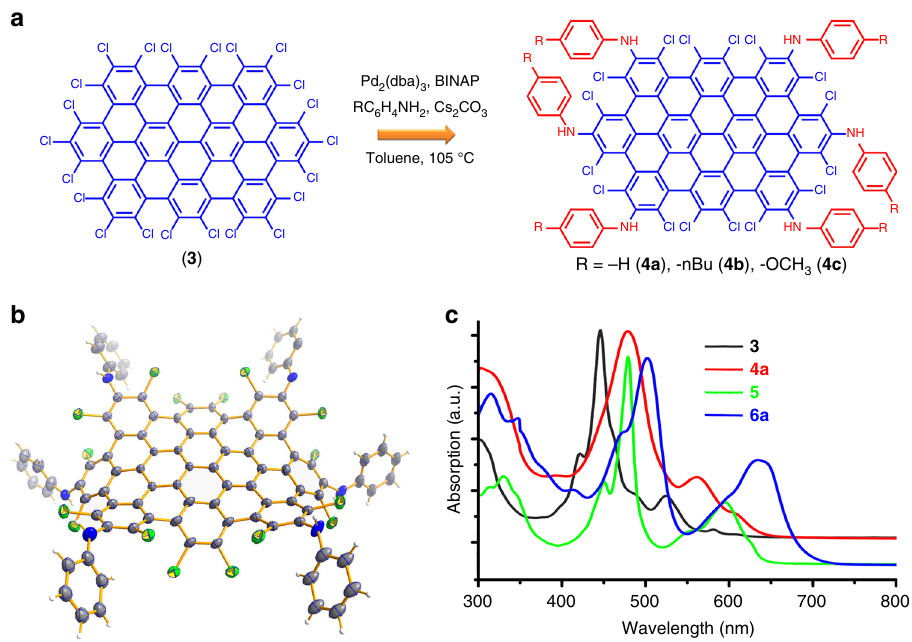
Fig. 4 Synthesis and crystal of 4 and optical absorption. a optimized synthetic route for 4 . b the crystal structure of 4 represented by 4a . The thermal ellipsoids were set at 30% probability level. c UV-Vis absorption spectra of 3 , 4a , 5 , and 6a . Notably, the molar absorption coef fi cients of 3 , 4 , and 6 were listed in Supplementary Figs. 47 – 49, while that of 5 can not be measured due to its extremely low